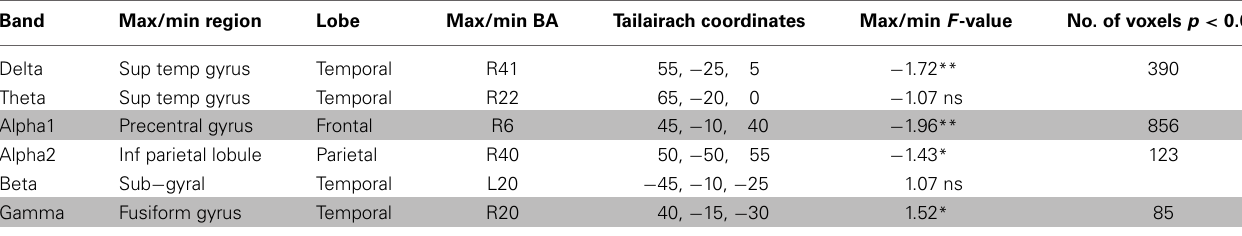
Table 3 | SYT > SYS comparison for control condition (Mental